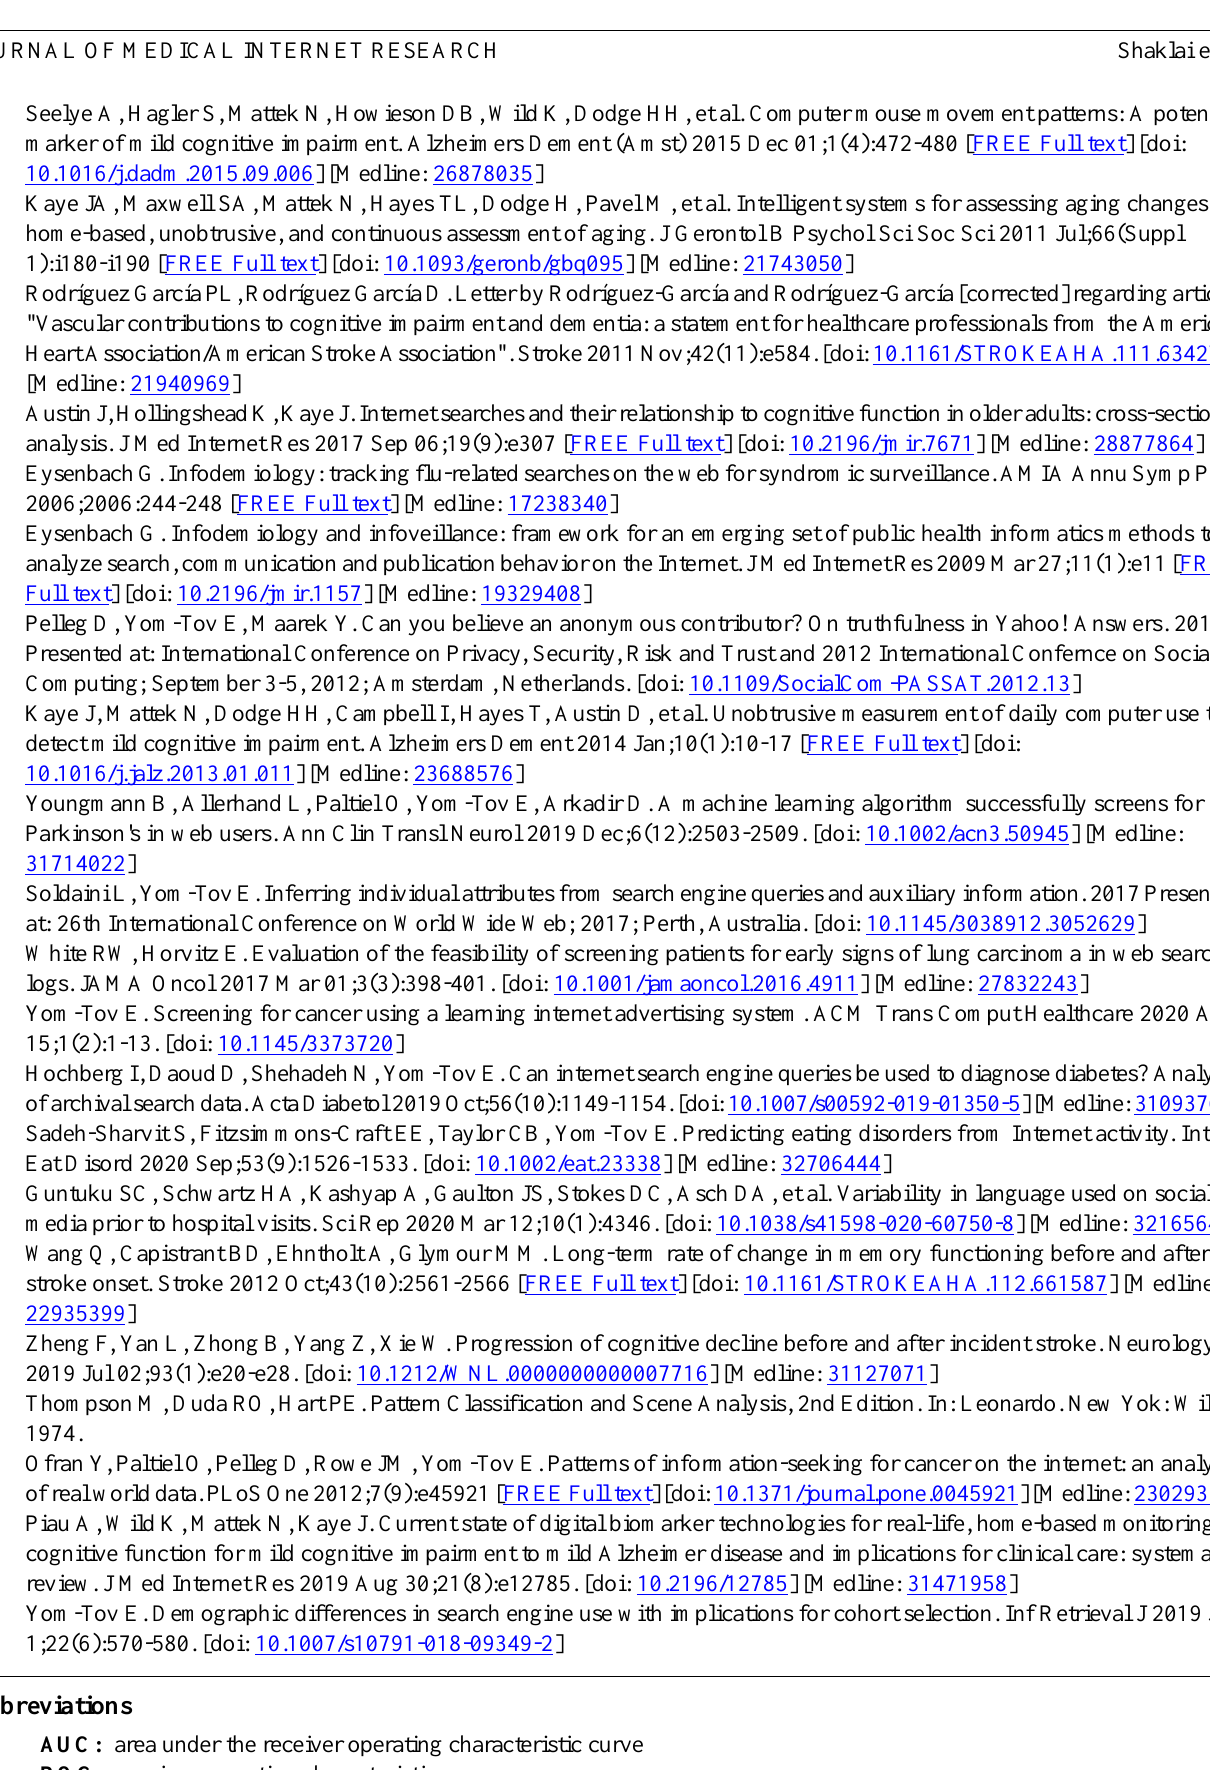
Abbreviations AUC: area under the receiver operating characteristic curve ROC: receiver operating characteristic